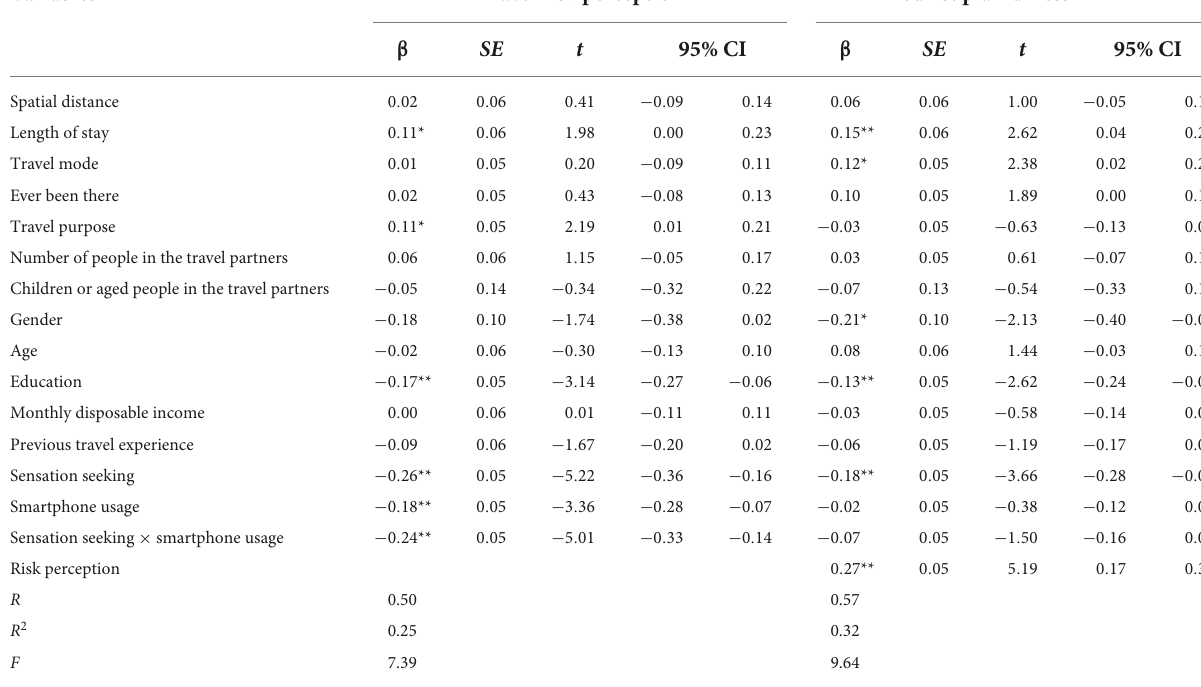
TABLE 3 Regression results for moderated mediation